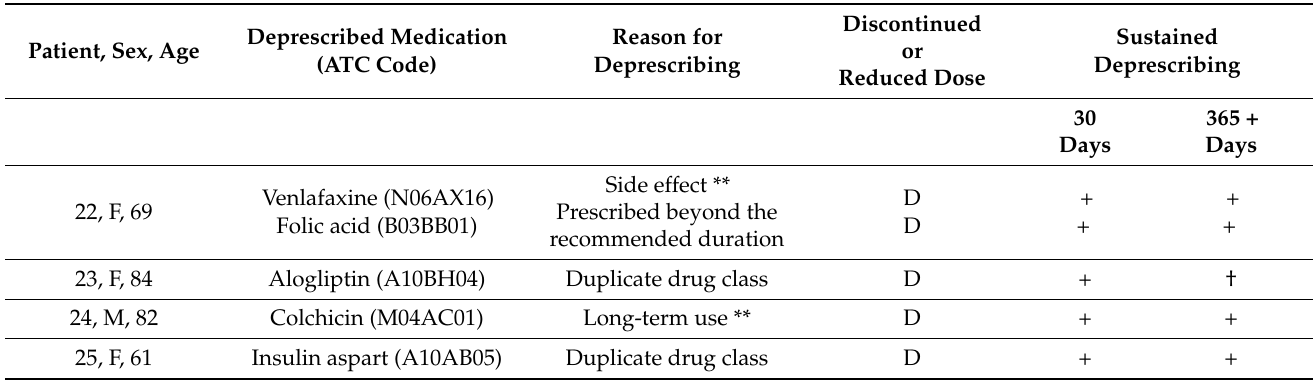
Table A2. Detailed overview of each deprescribed medication, reason for deprescribing, and whether the deprescribing status was sustained at 30 days and 365+ days post inclusion in the control